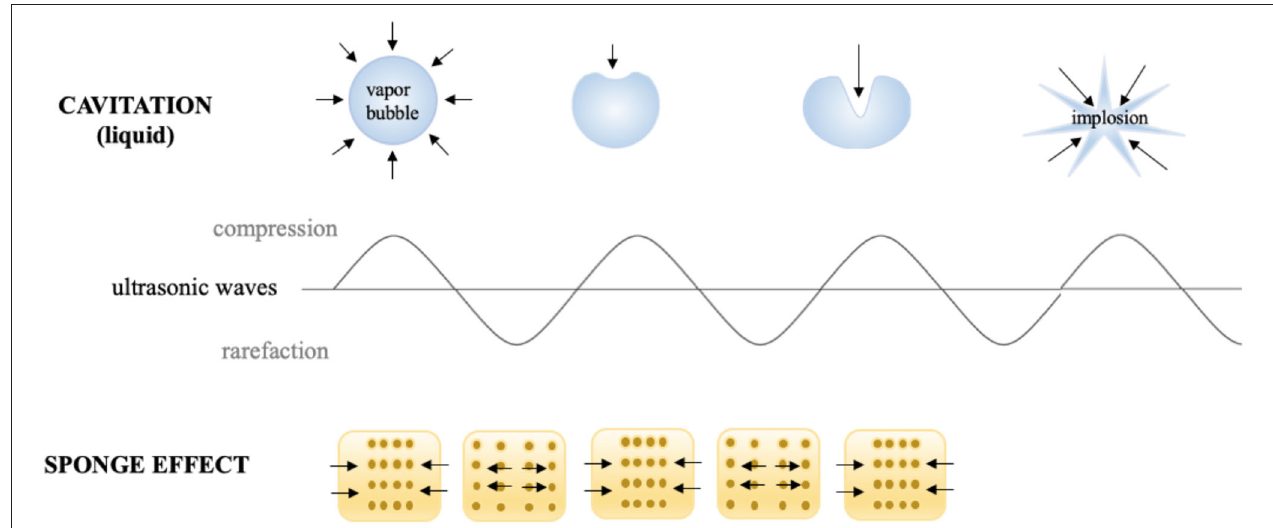
FIGURE 1 | Cavitation and sponge effect due to